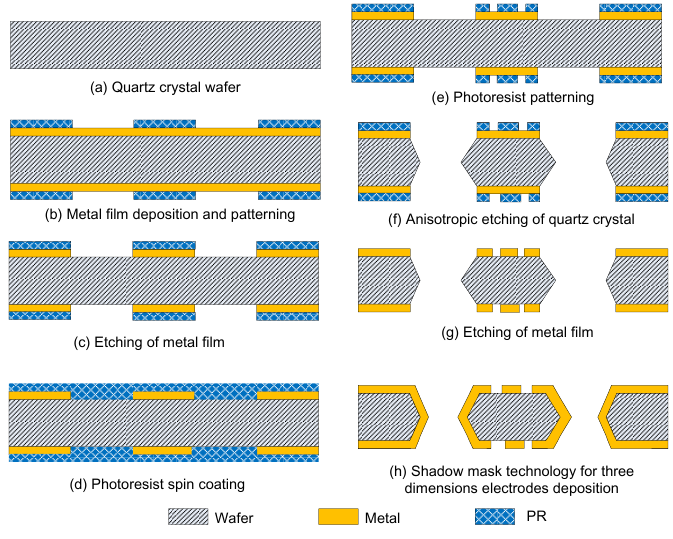
Figure 3. Schematic fabrication process of the DETF resonator.